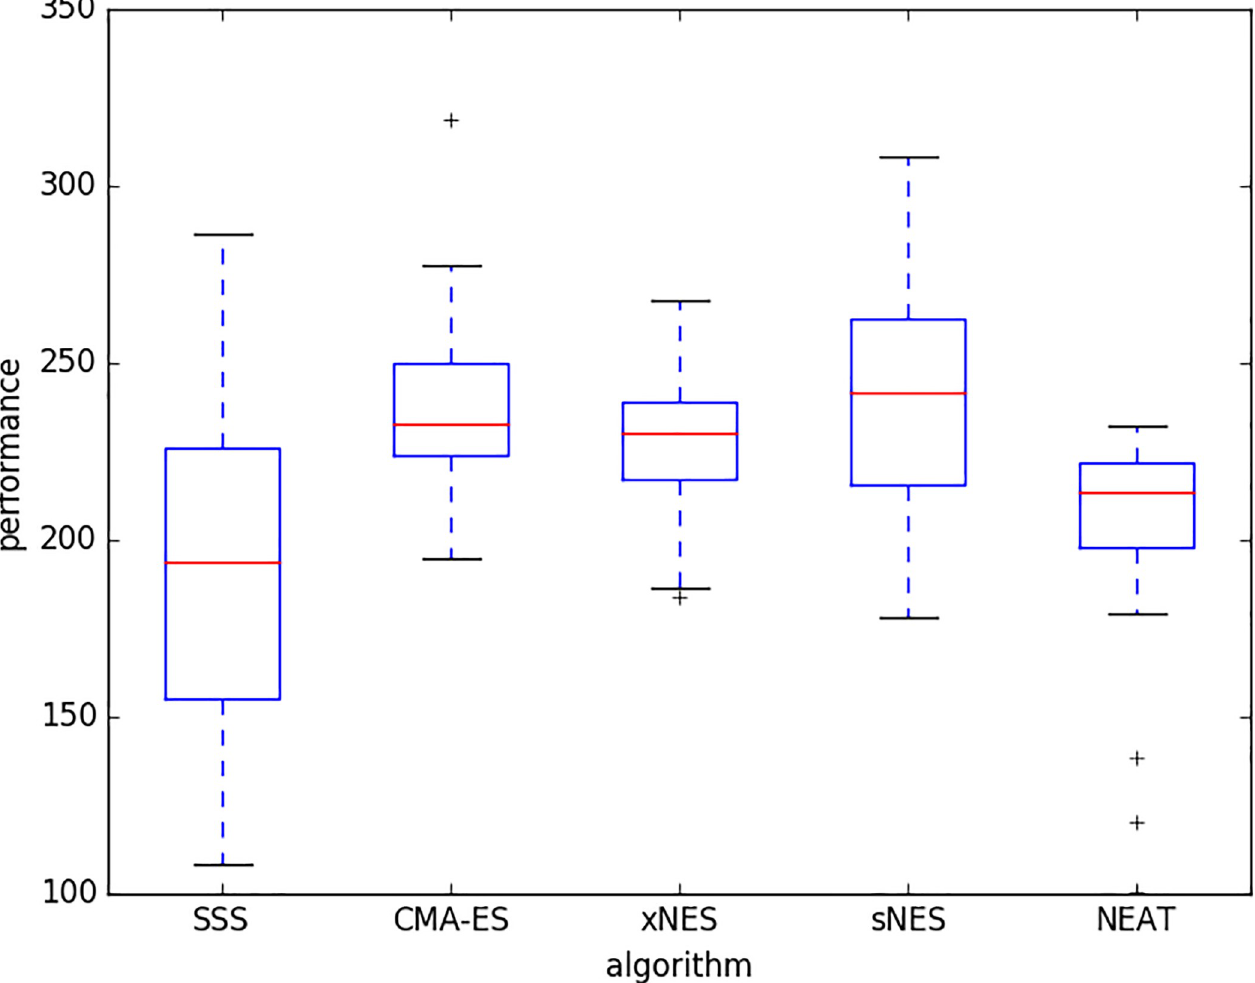
Fig 10. Performance of the best solution post-evaluated for 20 episodes. Boxes represent the inter-quartile range of the data and horizontal lines inside the boxes mark the median values. The whiskers extend to the most extreme data points within 1.5 times the inter-quartile range from the box. “+” indicate the outliers. Data have been obtained by running 30